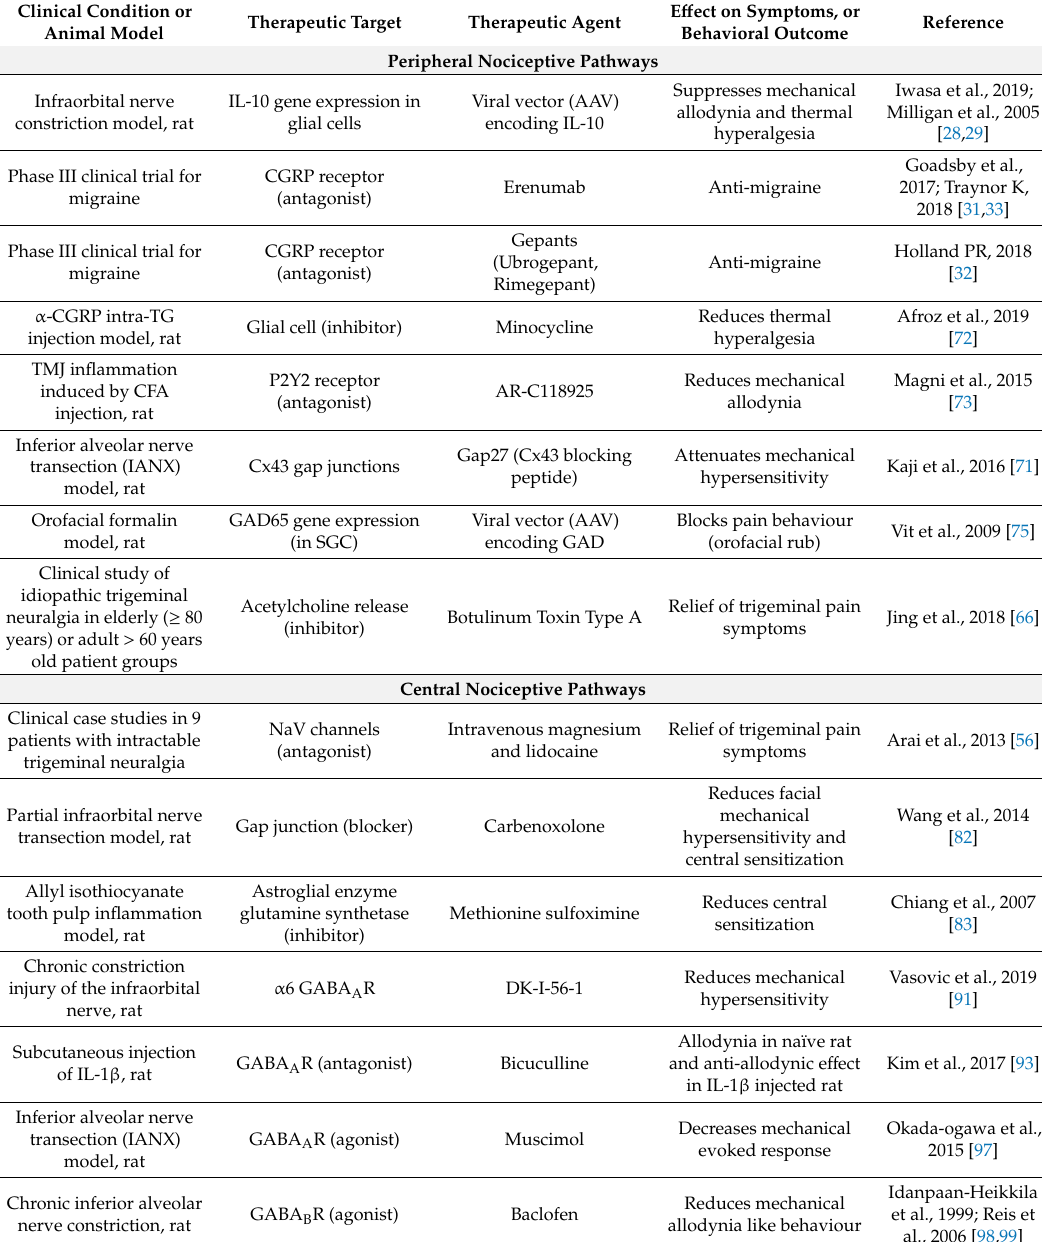
Table 1. Clinical and pre-clinical therapeutics for the treatment of trigeminal neuropathic